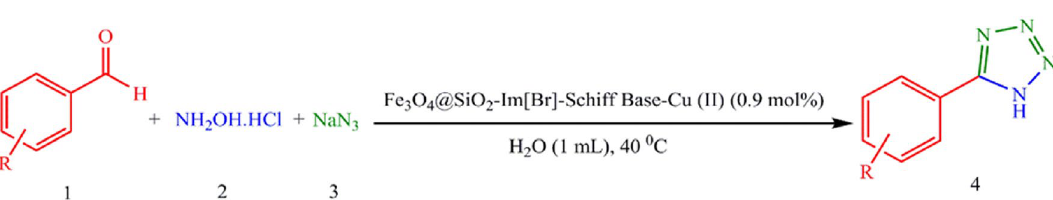
Figure 13. The synthesis of 5-aryl 1- H tetrazole derivatives.